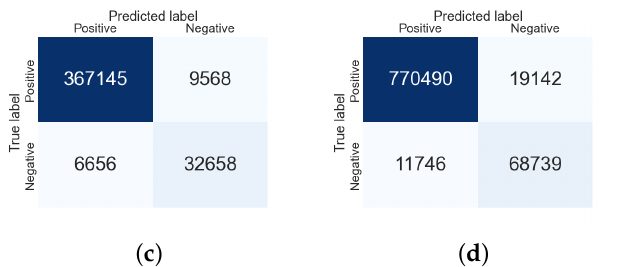
Figure 5. Confusion matrices for the evaluation percentages presented in Table 6, namely TP, TN, FP, FN rates, for PeX’s execution per technique and subset; ( a ) Normal Subset; ( b ) NormalVsMalicious01 Subset; ( c ) NormalVsMalicious02 Subset; ( d ) FullSet